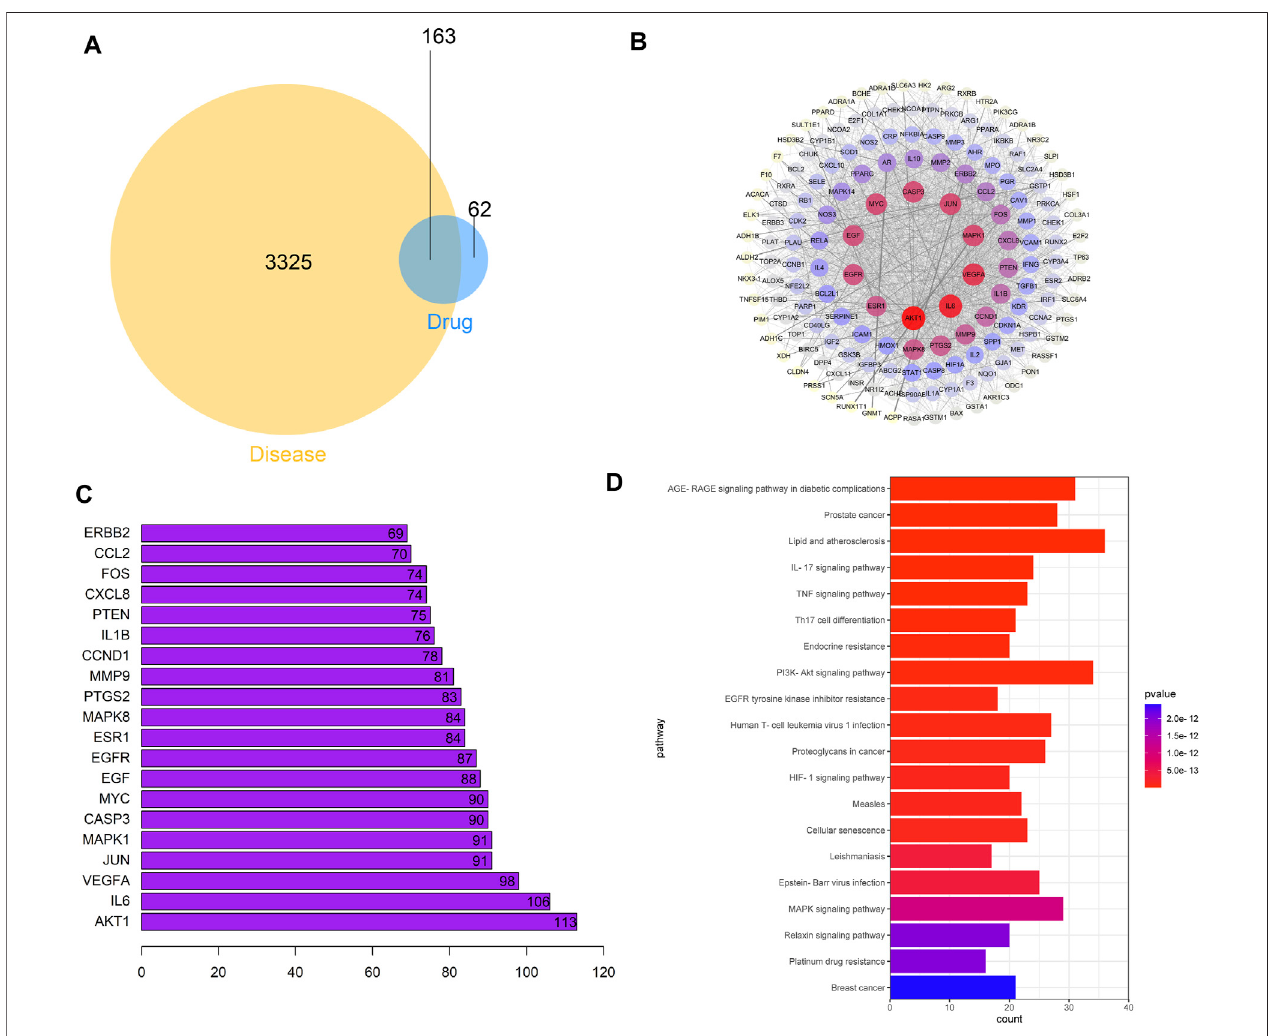
FIGURE 1| Potential effect mechanism ofA – S for treating PCa based on network pharmacology analysis. (A) Venn diagrams of common targets in PCa and A – S. (B) Construction of the PPI network in A – S in treating PCa by using the STRING database. (C) The top 20 core gene visualization was obtained by using R software according to the relevance number of nodes. (D) KEGG pathway analysis of core targets and column plot for top 20 pathways.